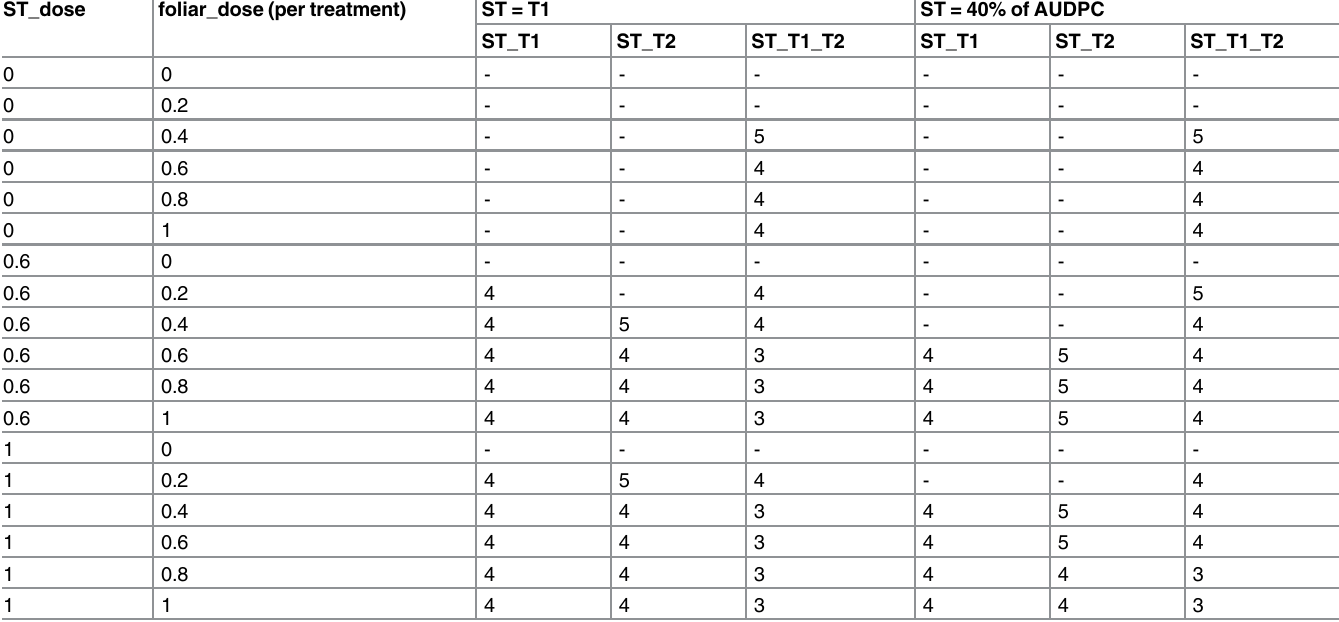
Table 3. Effective lives for two seed treatment efficacy parameterizations. foliar_dose (per